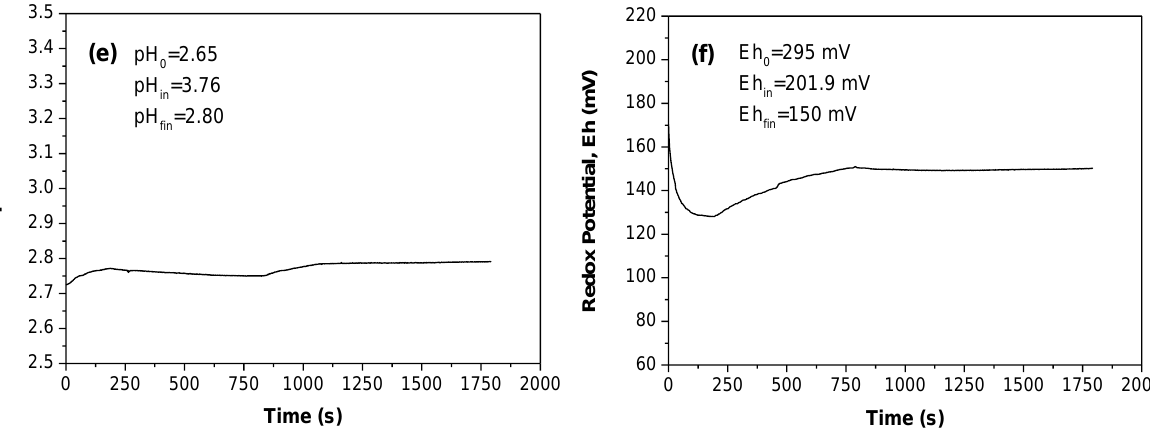
Figure 3. Transient response of (a, c, e) pH, and (b,d,f) Redox Potential, Eh, during the synthesis of nZVI suspensions by injecting (a,b) Green Tea (GT) extract in FeSO4·7H 2 O solution, (c,d) Pomegranate (PG) extract in FeSO4·7H 2 O solution,